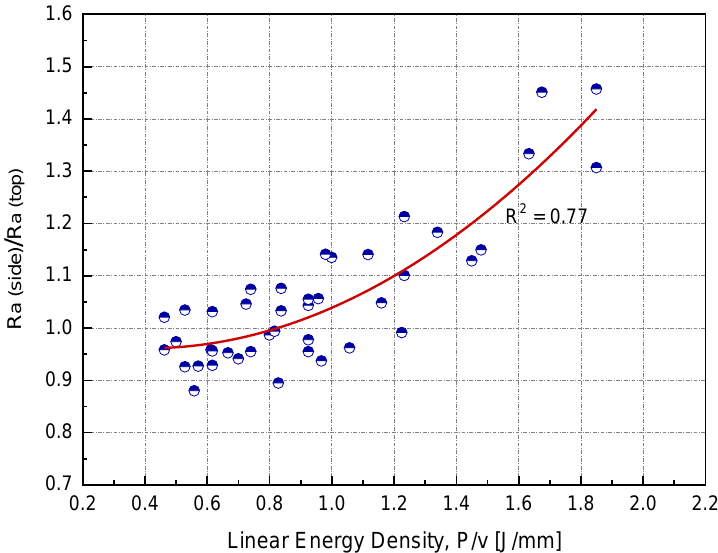
Figure 10. Relationship between the surface roughness ratio and linear input energy at the optimum hatch spacing ( h ) for Cu samples manufactured by L-PBF.